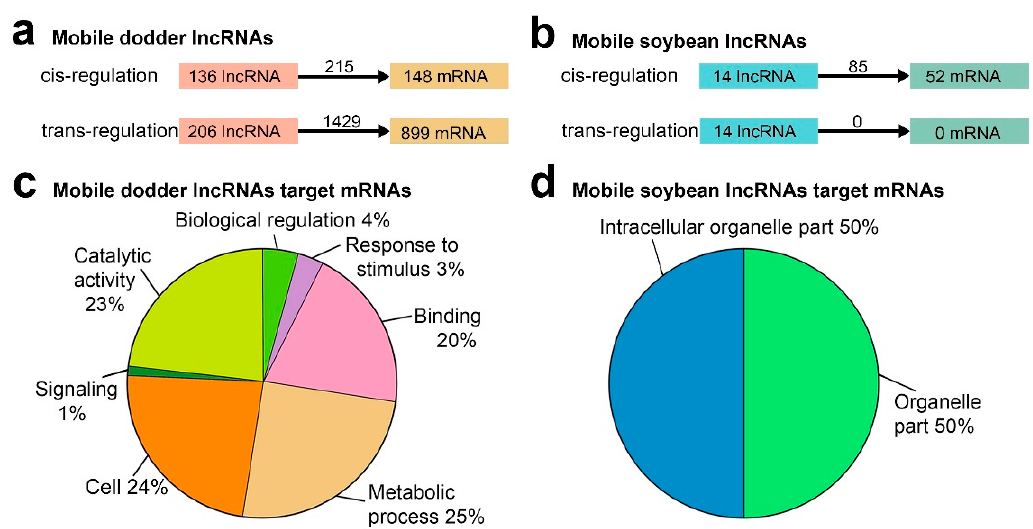
Figure 6. Functional analysis of mobile lncRNAs in parasitic systems: ( a ) Schematic diagram of mobile dodder lncRNAs regulating mRNAs; ( b ) Schematic diagram of mobile soybean lncRNAs regulating mRNAs. The numbers of regulatory relationship pairs are shown on the black arrows; ( c ) Pie charts showing the percentages of Gene Ontology (GO) slim terms enriched by mobile dodder lncRNAs target genes by WEGO 2.0 ( p -value < 0.05); ( d ) Pie charts showing the percentages of GO slim terms enriched by mobile soybean lncRNAs target genes by WEGO 2.0 ( p -value < 0.05). The full list of GO slim terms for these data is presented in Supplementary Table S4a.